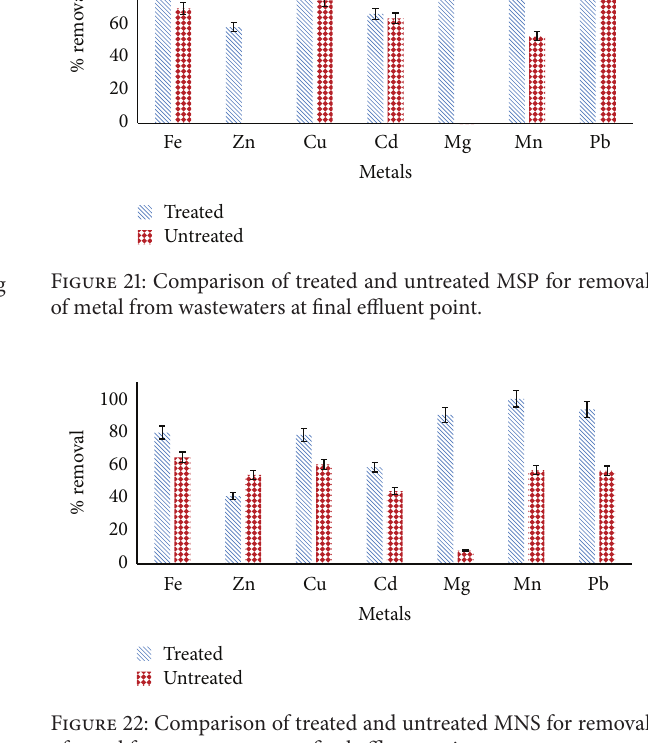
Figure 20: Percentage removal of metals from borehole water using MNS.